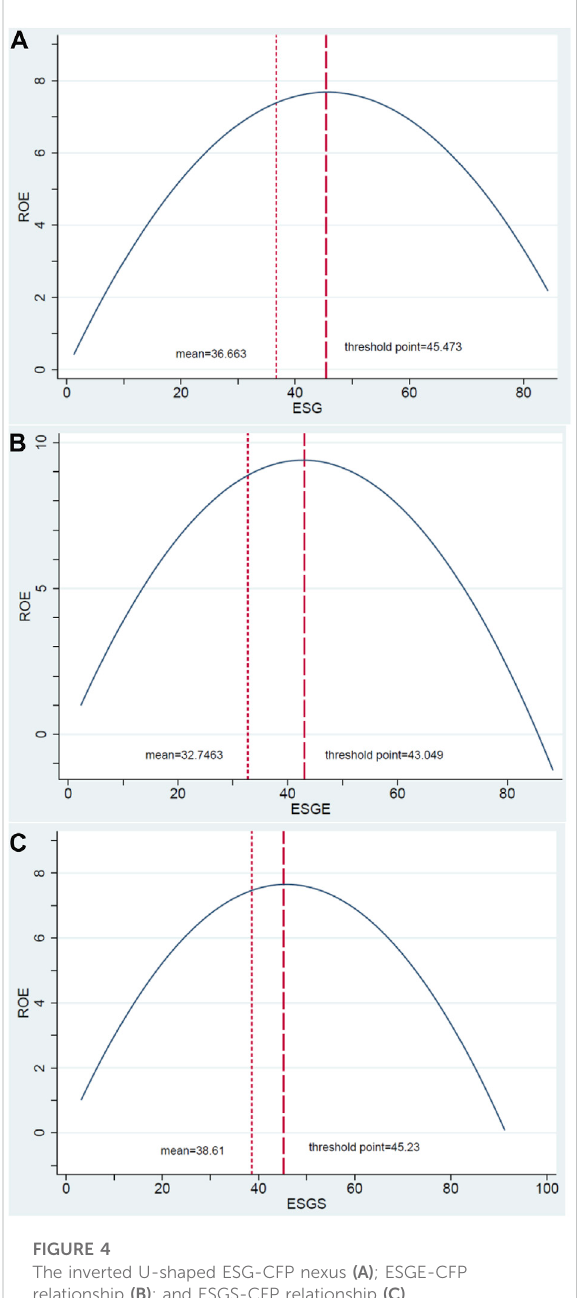
FIGURE 4 The inverted U-shaped ESG-CFP nexus (A) ; ESGE-CFP relationship (B) ; and ESGS-CFP relationship (C)